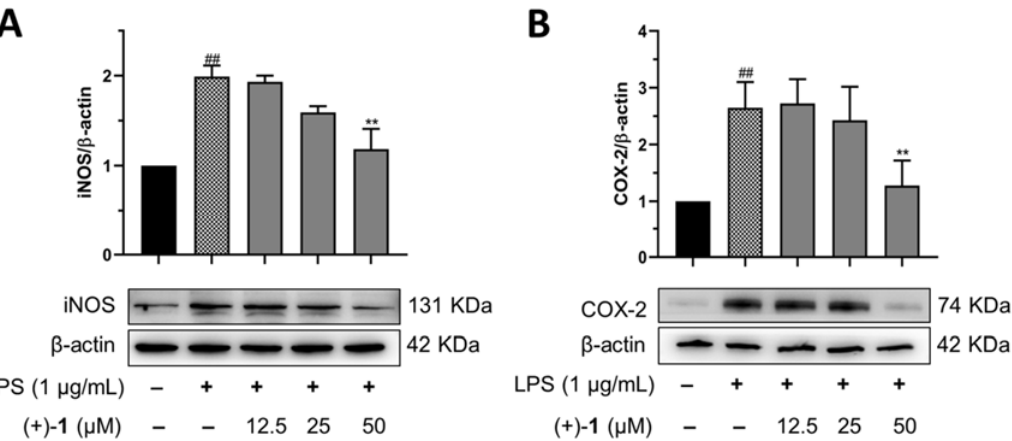
Figure 7. Effects of compound (+)- 1 on inflammation-related protein expression on RAW 264.7 cells. ( A ) Compound (+)- 1 decreased iNOS expression levels. ( B ) Compound (+)- 1 decreased COX-2 expression levels. Expression ratios of data are shown as mean ± SEM of three independent experiments and normalized with β -actin. ## p < 0.01 vs. control group, ** p < 0.01 vs. model group.